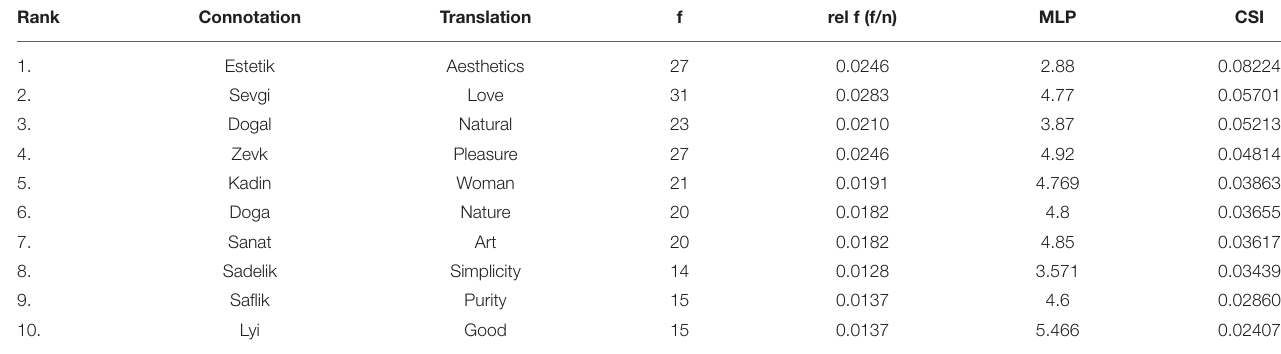
TABLE 1 | Cognitive salience